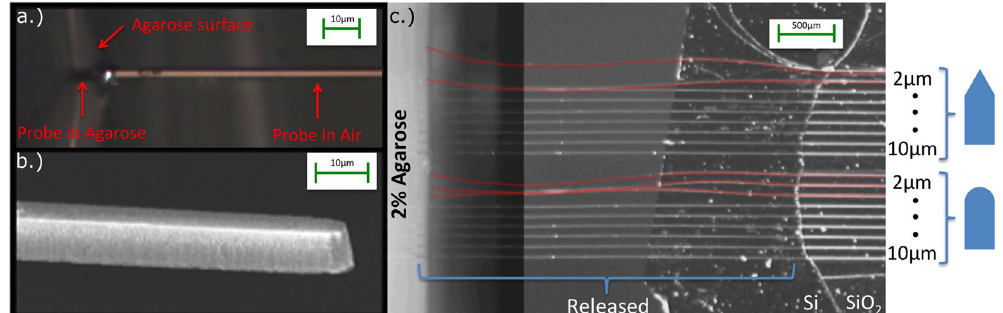
Figure 3. ( a ) Microscope image of a 3.25 mm long suspended probe with 3 × 10 μ m cross-section being inserted into 0.5% agarose by weight, to simulate mouse cortex without dura intact 44, 45 . ( b ) SEM image of the probe shown in ( a ) after release and before insertion. ( c ) Composite microscope image of released probes with two different tip geometries and widths varying from 2 to 10 μ m being inserted into 2% agarose by weight to simulate mouse cortex with dura intact 44–47 . The Photonic Needles that buckled during insertion are shown in